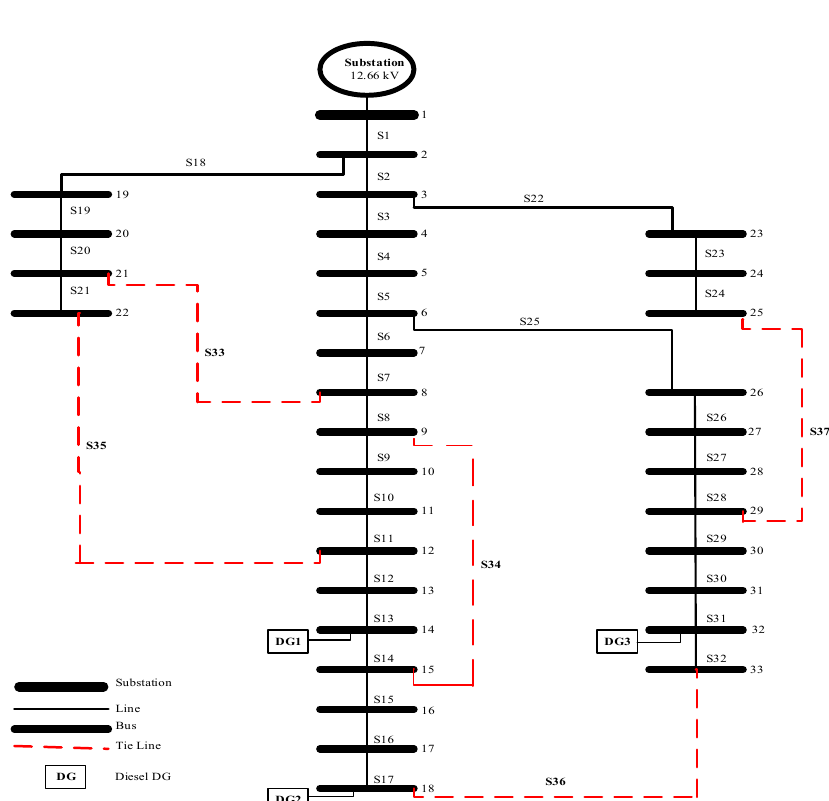
Figure 1. The standard IEEE 33-bus test system considered as a reconfigurable microgrid (RMG). The total real and reactive power demand of the test system is 3715 kW and 2300 kVAr, respectively. The load data and line data can be found in [35]. Three diesel DGs with 4 MW total real power capacity operated at a unity power factor are installed in di ff erent buses, as stated in Table 1. Table 1. The characteristics of dispatchable units.